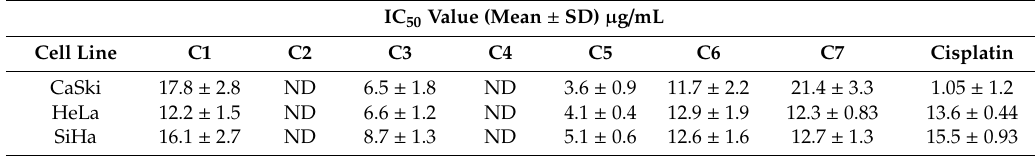
Table 2. IC 50 values for A. coriacea compounds and cisplatin in cervical cancer cell